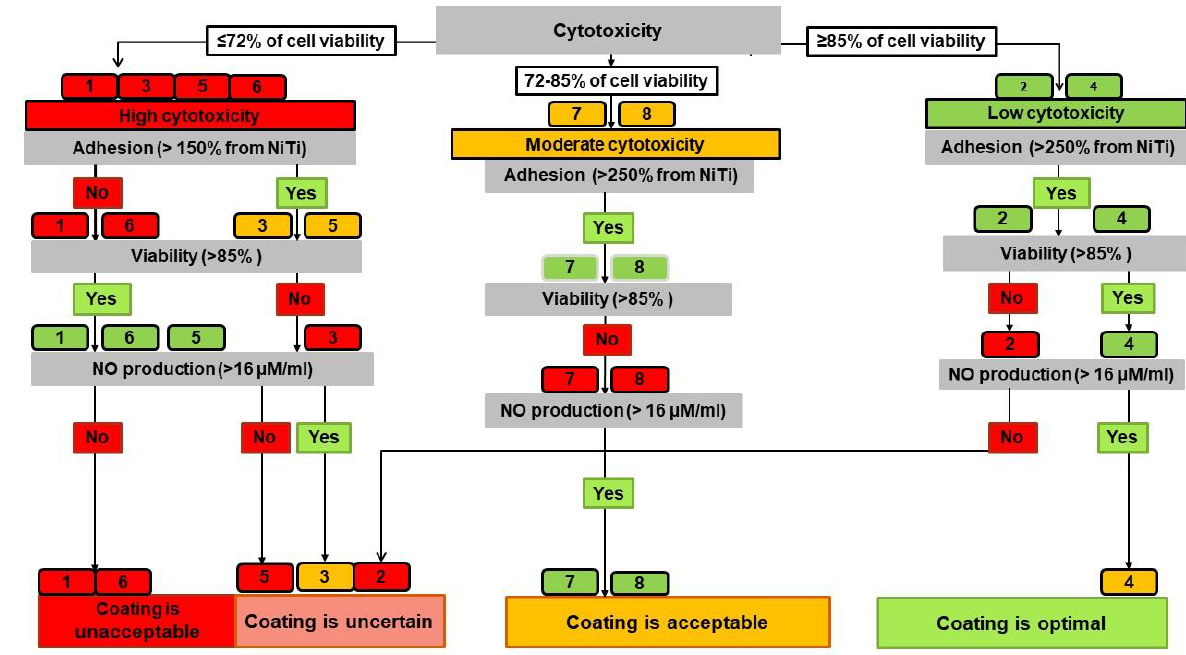
Figure 3. Decision tree algorithm for the cytocompatibility of TiO 2 - and N-TiO 2 -coatings.